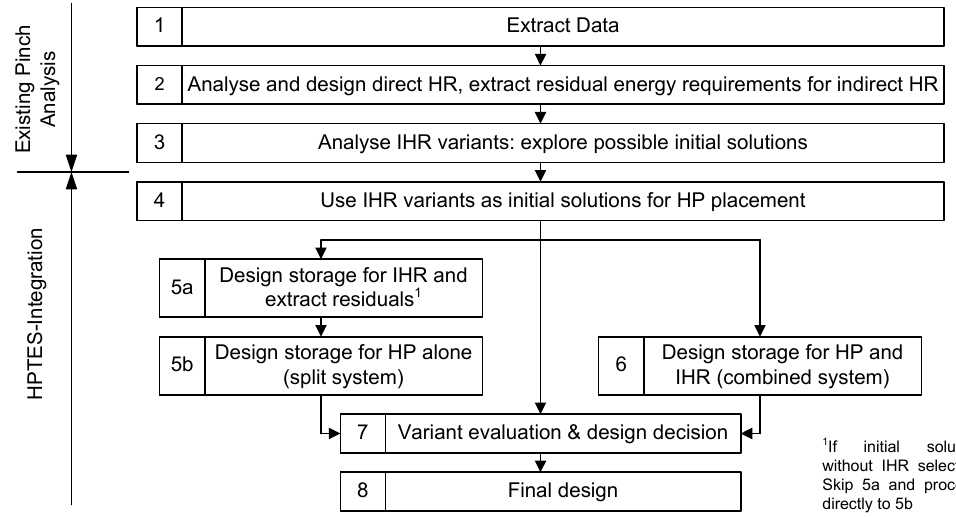
Figure 2. Workflow for the integration of HPTES system into non-continuous